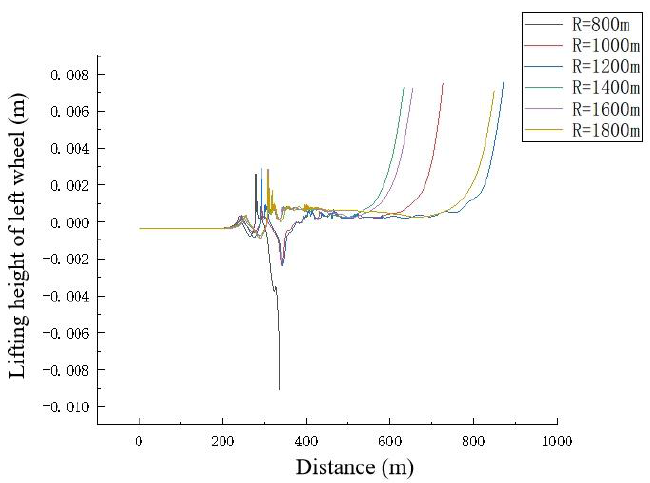
Figure 9. Wheel lifting height at outer rail side.